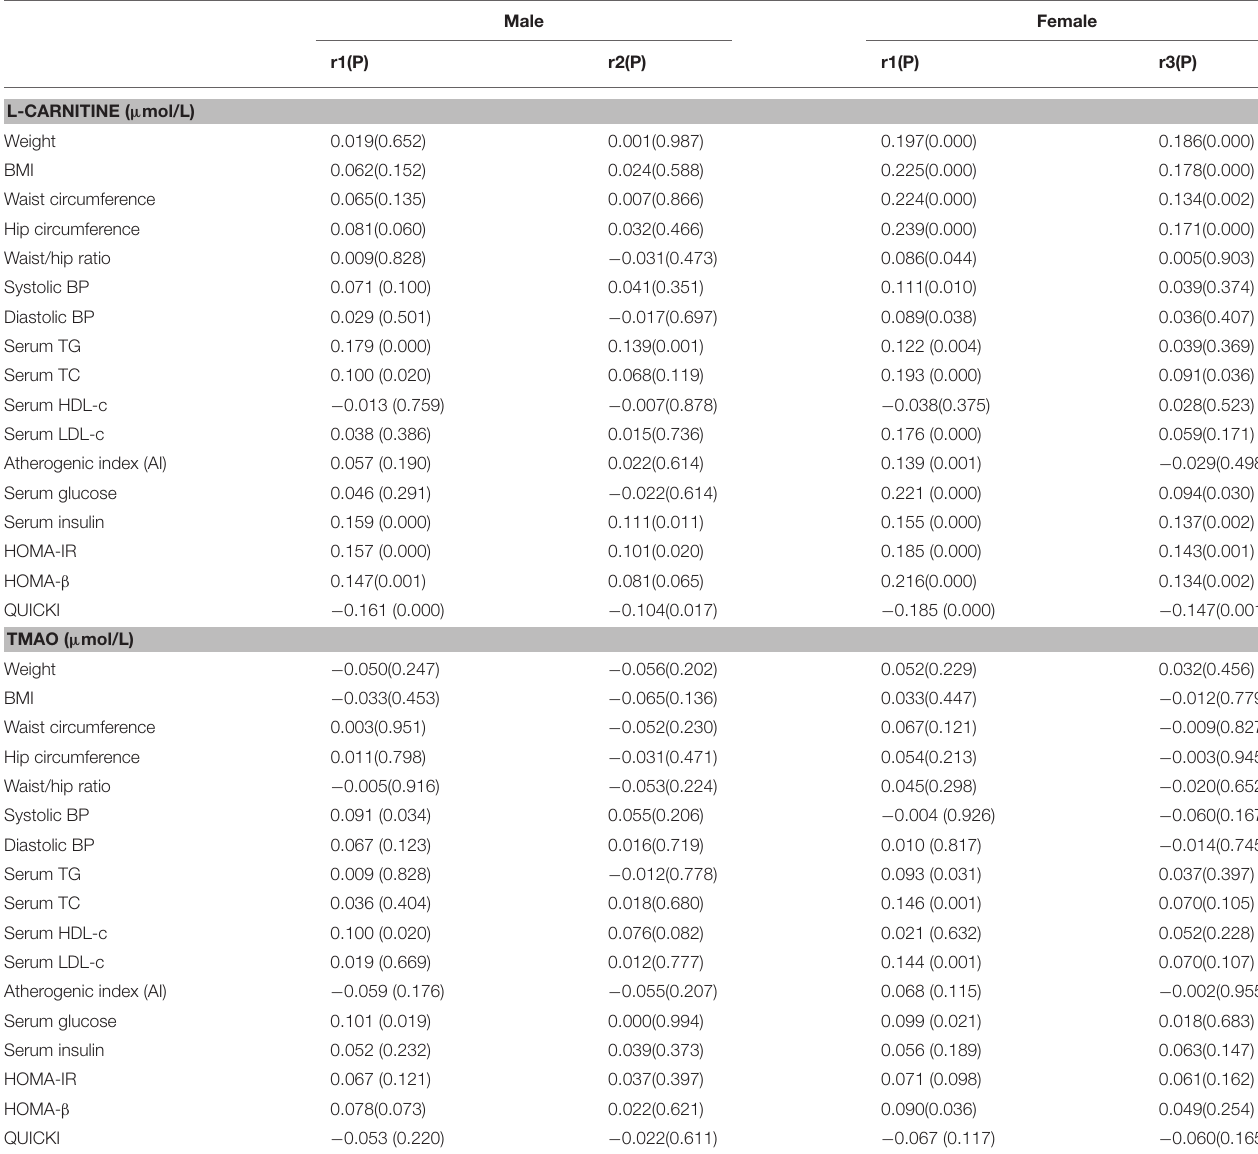
TABLE 2 | Partial correlations between serum L-carnitine, TMAO levels with components of MS in females and